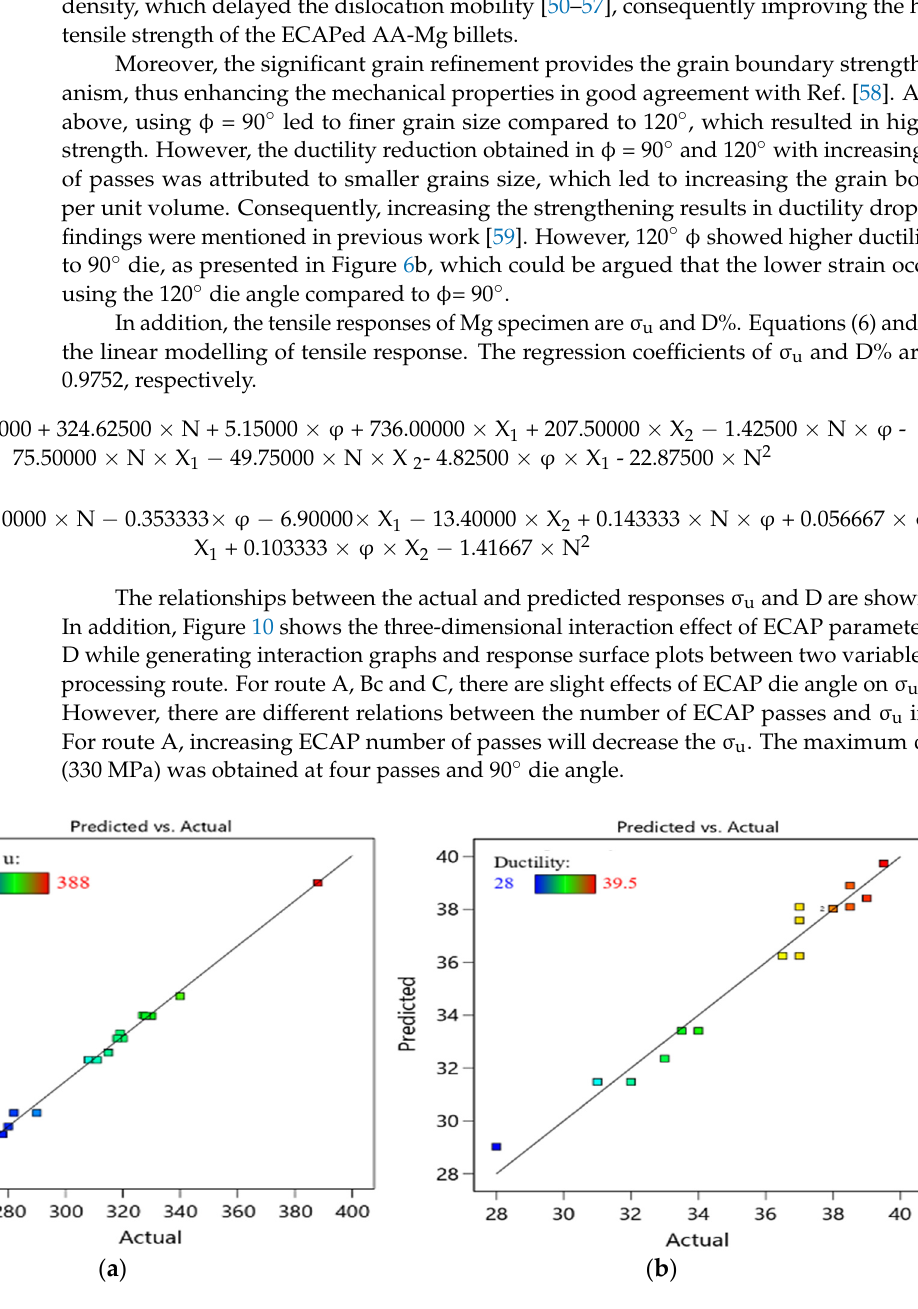
( f ) Figure 10. Three-dimensional plot of σ u ( a – c ) and D ( d – f ) with N and ϕ at route A ( a , d ), Bc ( b , e ) and C ( c , f ). Furthermore, analysis of variance (ANOVA) is used to examine independent param- eters, N, φ , X 1 and X 2 , in order to determine which ones have a significant impact on per- formance parameters, G R , H C , H E , σ u and D [60]. The significant effects with p -values less than 0.05 indicate that the independent parameters, as well as the individual model coef- ficients and interaction terms, are statistically different from zero at the 95% confidence level [61]. Table 3 presents the significant parameters of the five responses after eliminat- ing the insignificant effects using multiple regression analysis on experimental data. Table 3. Significant independent parameters for each ECAP response.